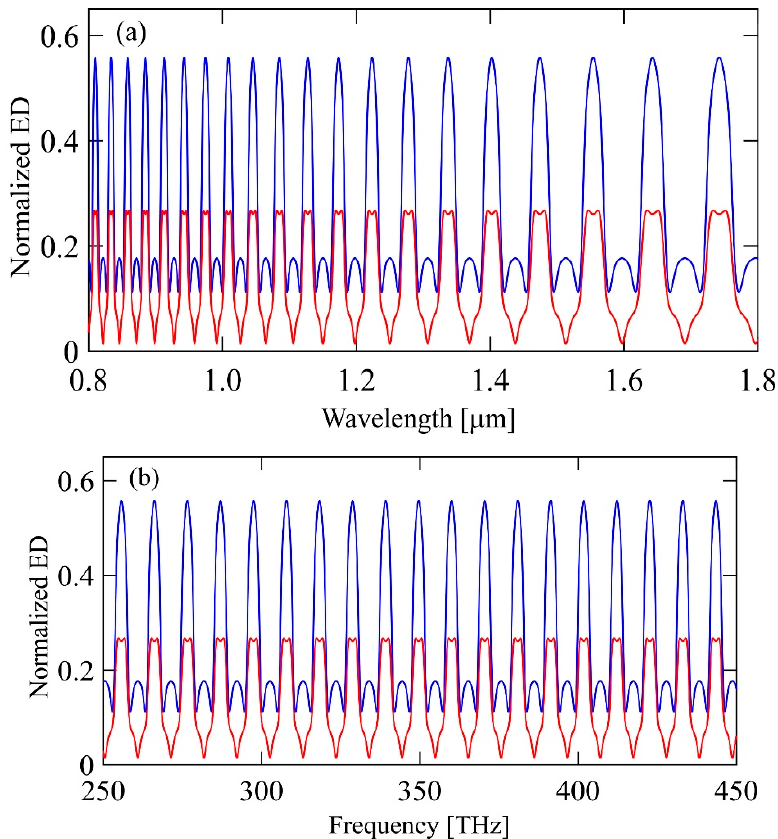
Figure 3. The plot of the delightfulness simulation signals where ( a ) is the wavelength domain, and ( b ) is the frequency domain where the blue and red colors are the polaritons’ spin-up and spin-down. This is the steady state of the energy–time function in terms of wavelength and frequency, respectively.